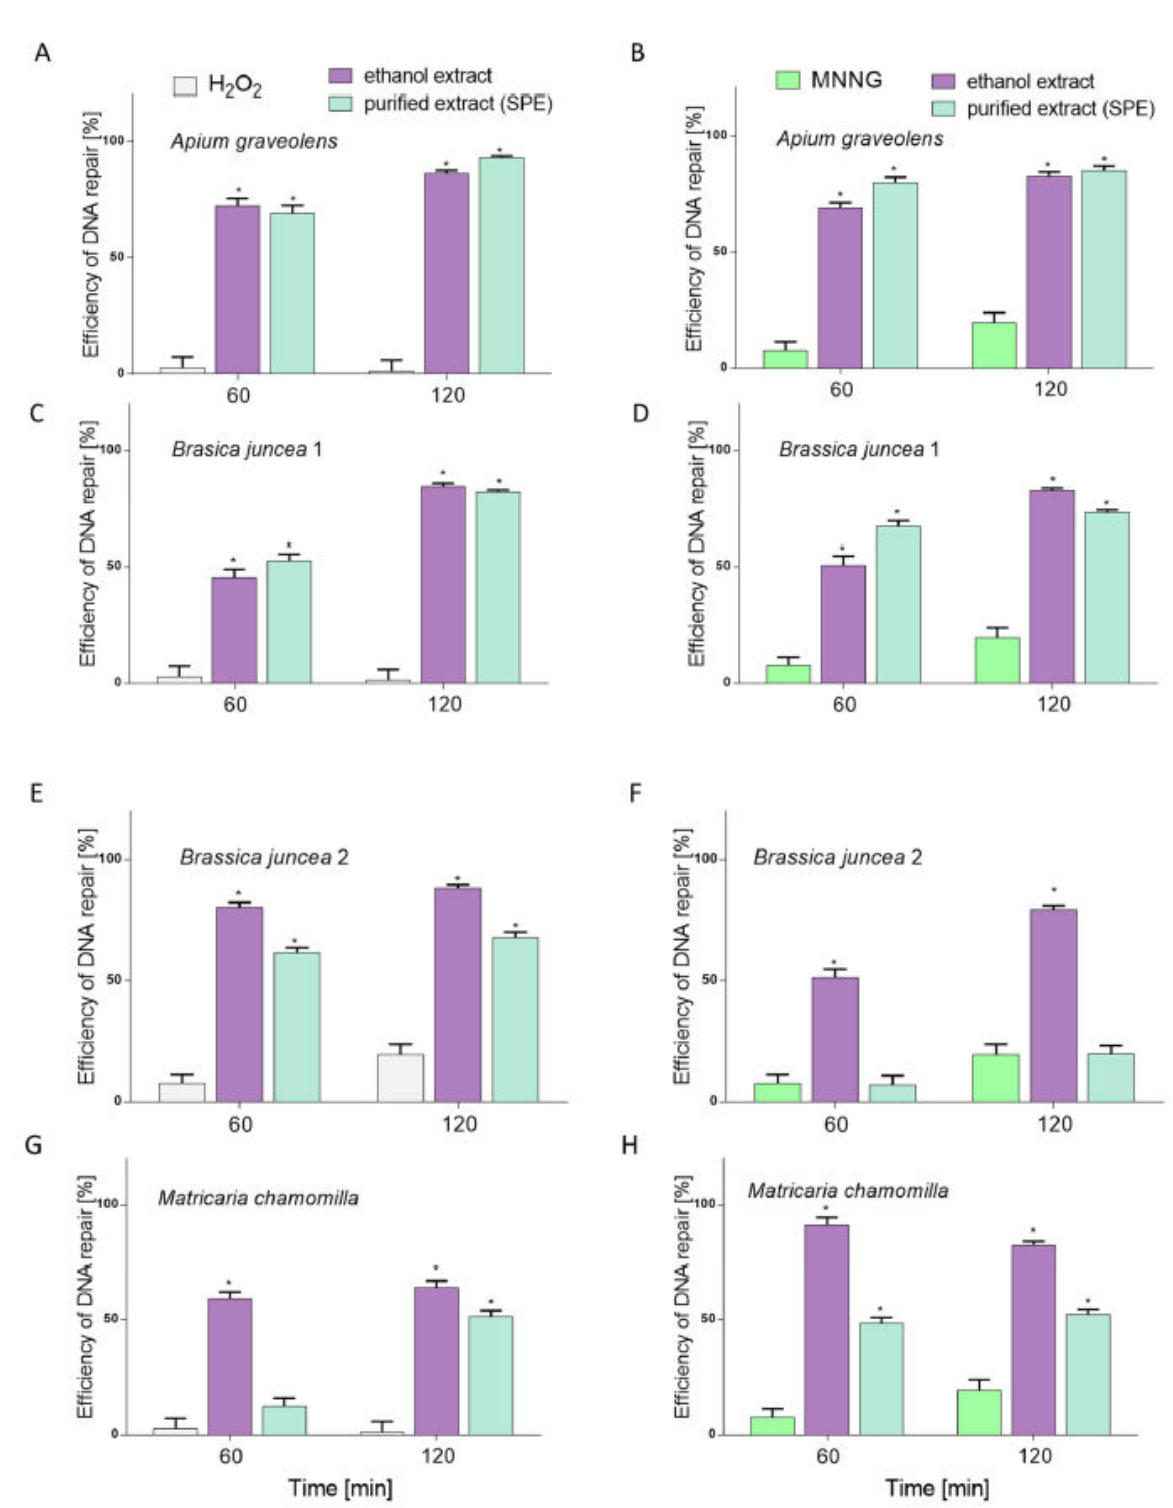
Figure 3. Efficiency of DNA repair (%) in Caco-2 cells exposed to 25 µ M H 2 O 2 ( A , C , E , G ) or to 6.8 µ M MNNG ( B , D , F , H ) for 10 min. Then cells were post-incubated for 60 and 120 min with the ethanolic extracts and the SPE-purified extracts (p) of Apium graveolens (AGE) ( A , B ), Brassica juncea 1 (BJE1) ( C , D ), Brassica juncea 2 (BJE2) ( E , F ) and Matricaria chamomilla (MCE) ( G , H ) at 0.25 mg/mL concentration. The number of cells analyzed for each time-interval was 50. Error bars denote S.E.M. ANOVA ( p < 0.05). * Significantly different from the positive